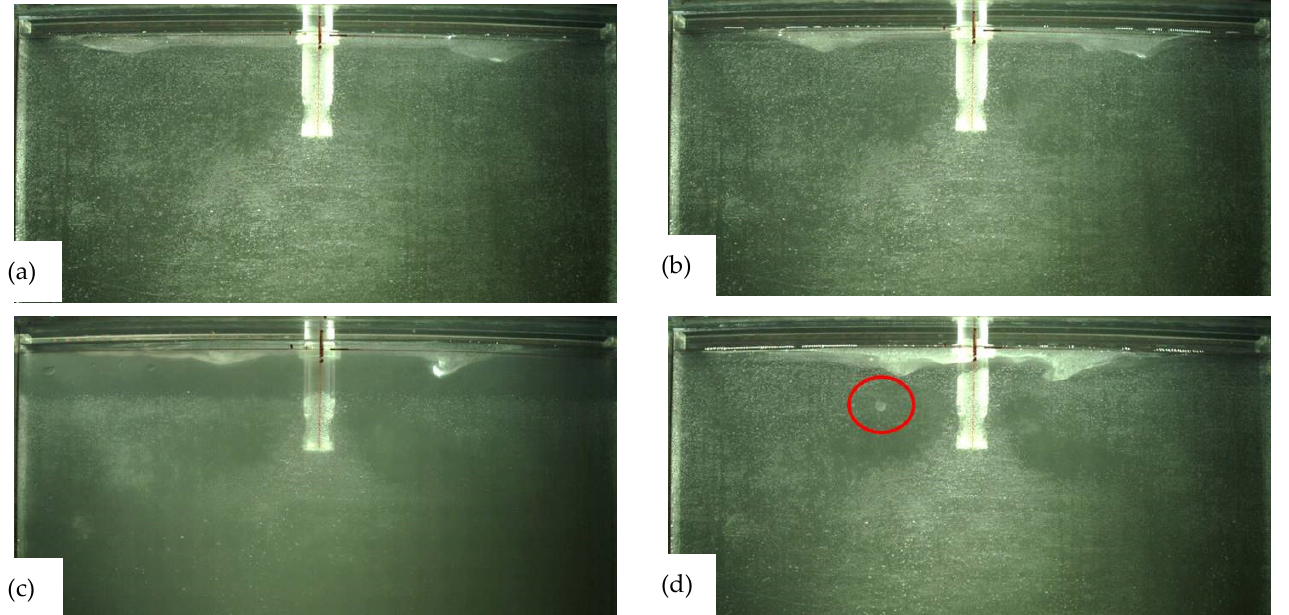
Figure 9. Water–oil interface phenomenon under different water model casting speed conditions ( a )